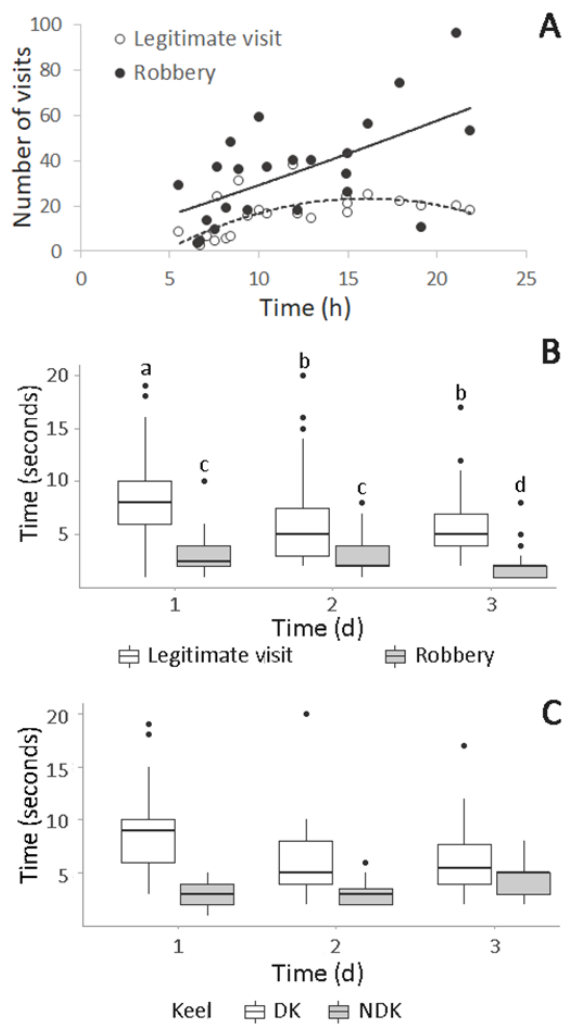
Figure 3. (A) Correlation between the time of a flower´s life (hours) and the number of legitimate visits to the flower (white circles, tendency in dotted line) and nectar robbery per flower including robbery to buds, open, closed and dead flowers (black circles, tendency in continuous line). (B) Box plots of total time spent by pollinators on legitimate visits ( Apis mellifera ) and robbery ( A. mellifera and Bombus terrestris ) in a flower´s life. Circles represent outliers. (C) Box plots of total time spent by A. mellifera down and non-down the keel (DK and NDK respectively) in a flower´s life. Error standard is showed, and circles represent